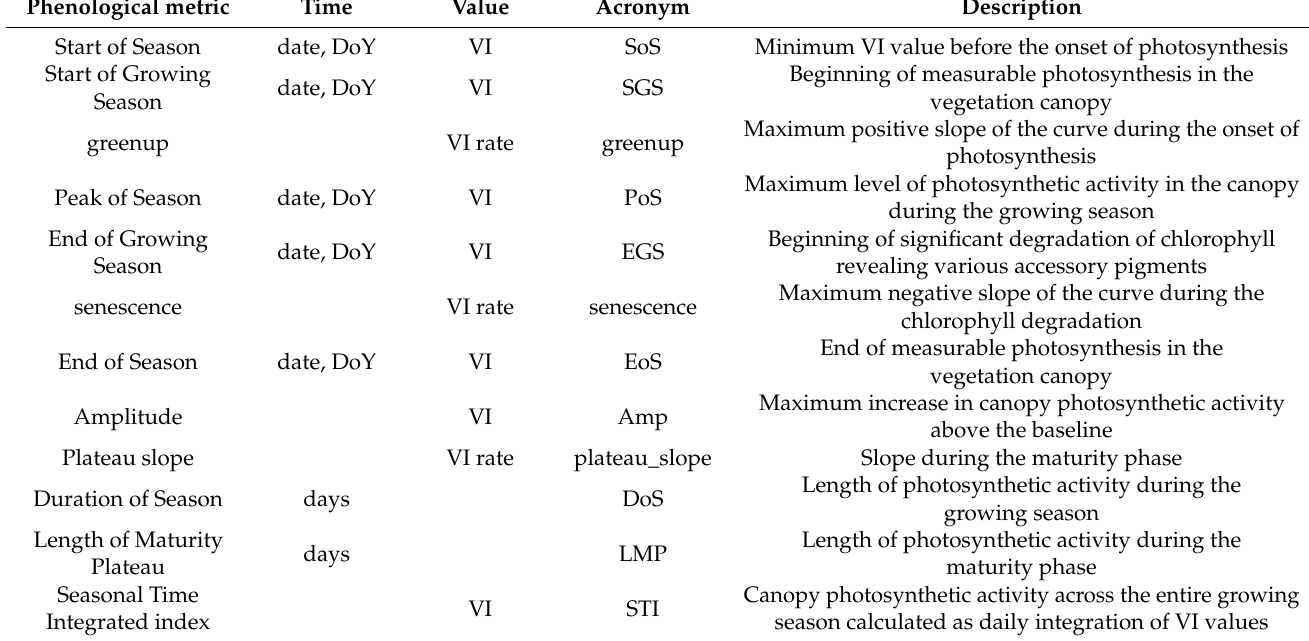
Table 2. List and description of the estimated phenological metrics used. Time field reports the units used for the estimation ( x -axis in Figure 2); Value field specify if vegetation index is computed for the corresponding phenological metric ( y axis in Figure 2). DoY: day of year, VI: vegetation